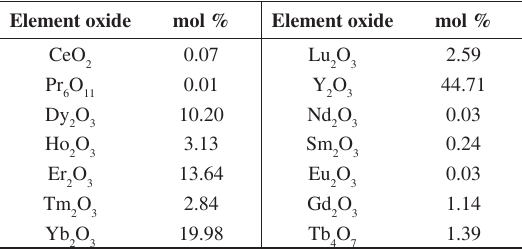
Table 1. Rare earth oxides content in xenotime. Element